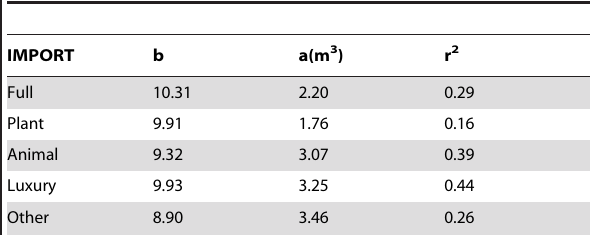
Table 4. Parameters obtained by fitting a power law to import strength and IHDI values (s i,imports =a IHDI ib ).